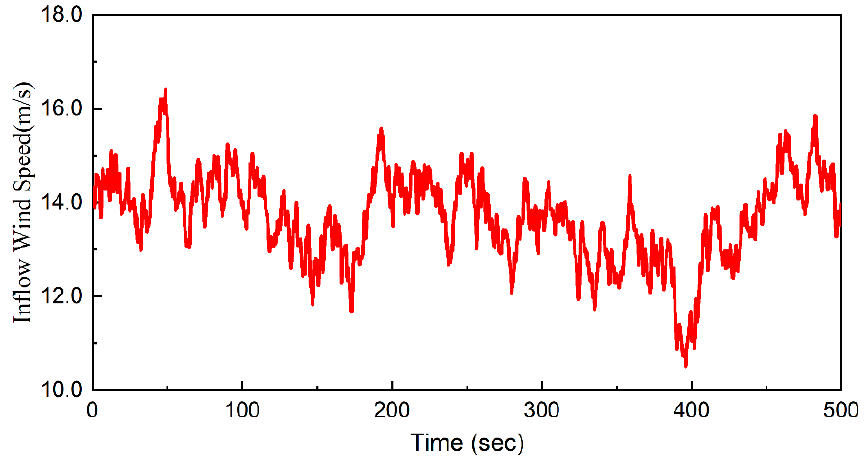
Figure 8. Time histories of wind speed.